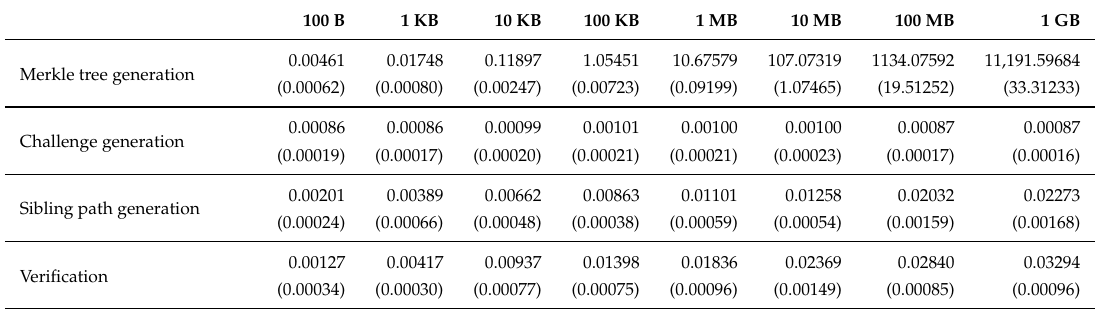
Table 2. Average computation time (ms) for authentication based on Merkle tree by data size (standard deviation in parentheses).